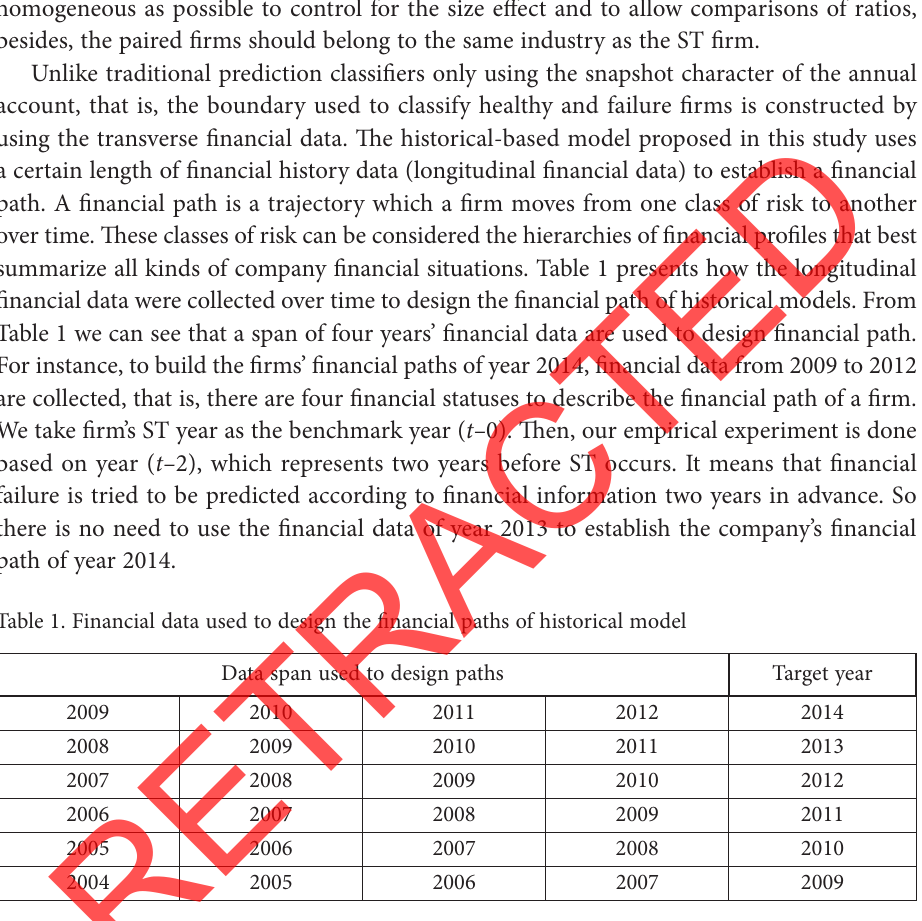
Table 1. Financial data used to design the financial paths of historical